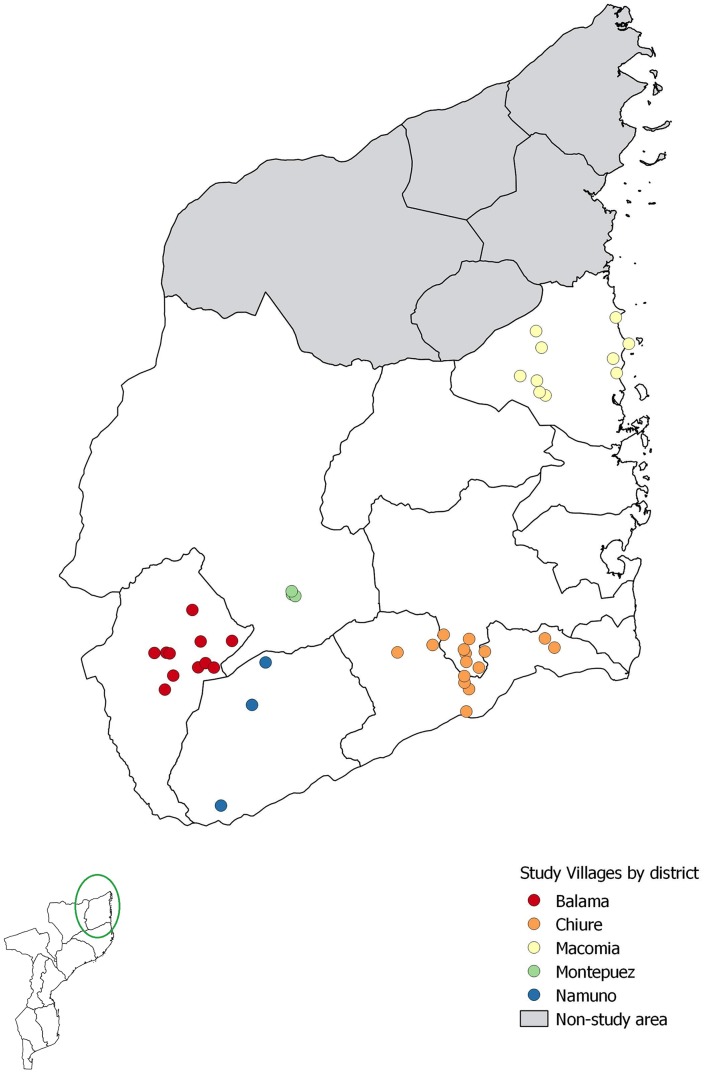
42 villages from 5 districts surveyed in the province of Cabo Delgado, northern Mozambique.We created the map using QGIS and publicly available shapefiles from http://www.diva-gis.org/gdata.